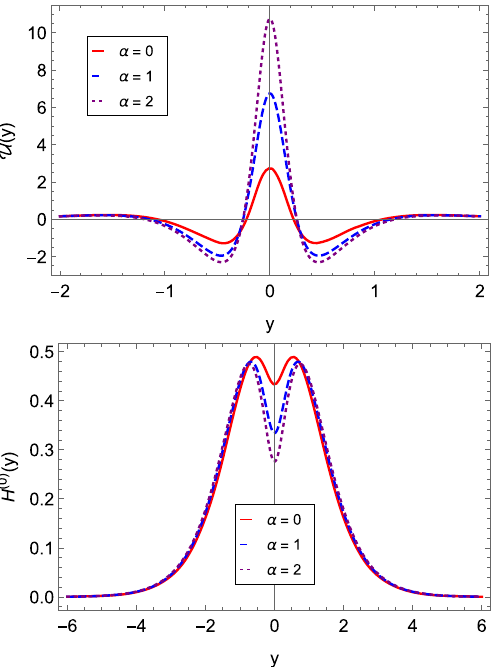
Fig. 11 Stability potential U ( y ) (top panel) and graviton zero-mode H ( 0 ) ( y ) (bottom panel) for the numerical solutions obtained in Sect. 2.3.2, with ϕ 0 = U 0 = k = φ 0 = A 0 = 1, ψ = − 5, for different values of α